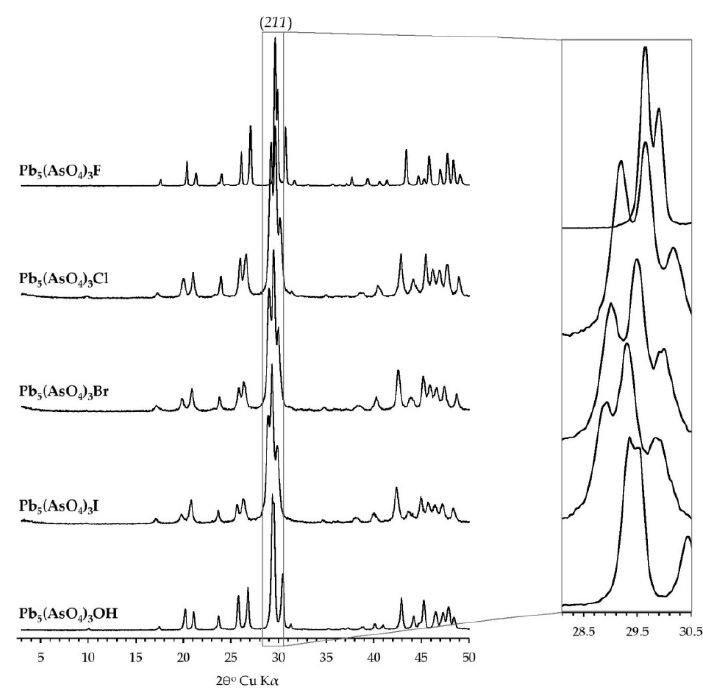
Figure 2. Laboratory X ‐ ray diffraction patterns of synthesized halogenated mimetites. All phases exhibited good crystallinity. No contamination was detected within the detection limit of the method. A systematic shift of peak positions is visible in the inset.